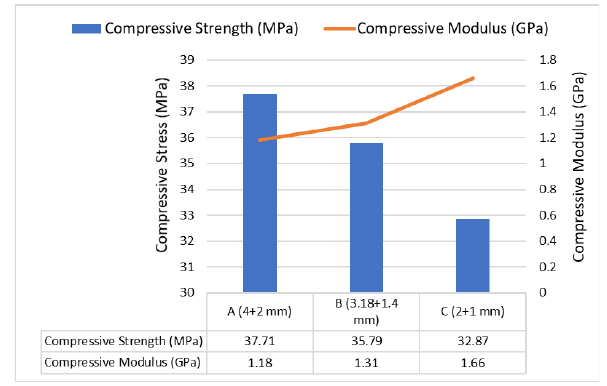
Figure 5: Graph of comparison of compressive strength and modu- lus variation with aggregate